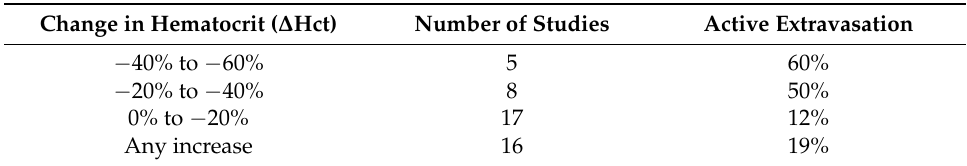
Table 2. Change in hematocrit over 24 h prior to angiography, for patients with suspected upper and lower gastrointestinal bleeding